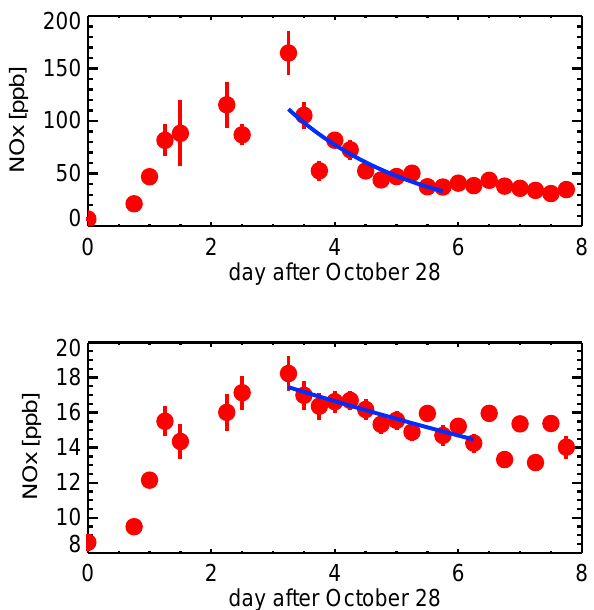
Fig. 1. MIPAS vmr measurements of NO x (red) at October– November 2003 and a fit of an exponential function (blue) between 50 ◦ S and 90 ◦ S and at 62km (top) and 45km (bottom) altitude. The error bars show the error of the mean of the zonal